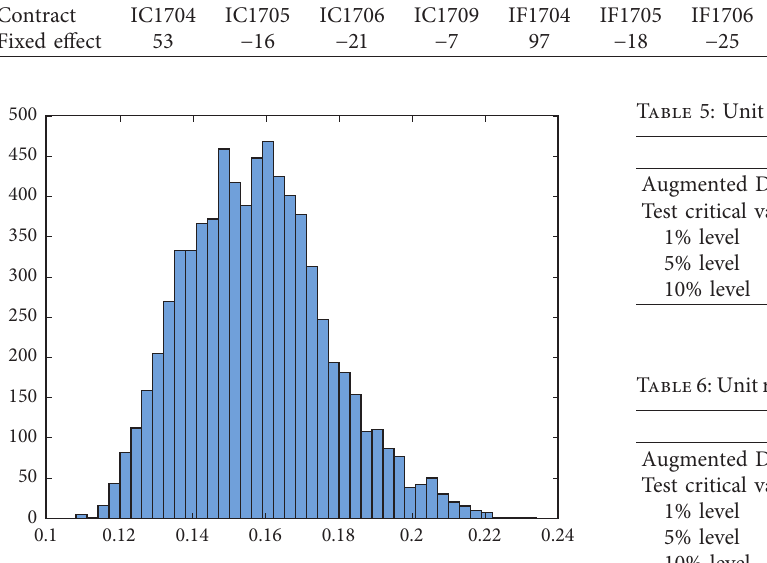
Figure 6: IH -VPIN distribution histogram.